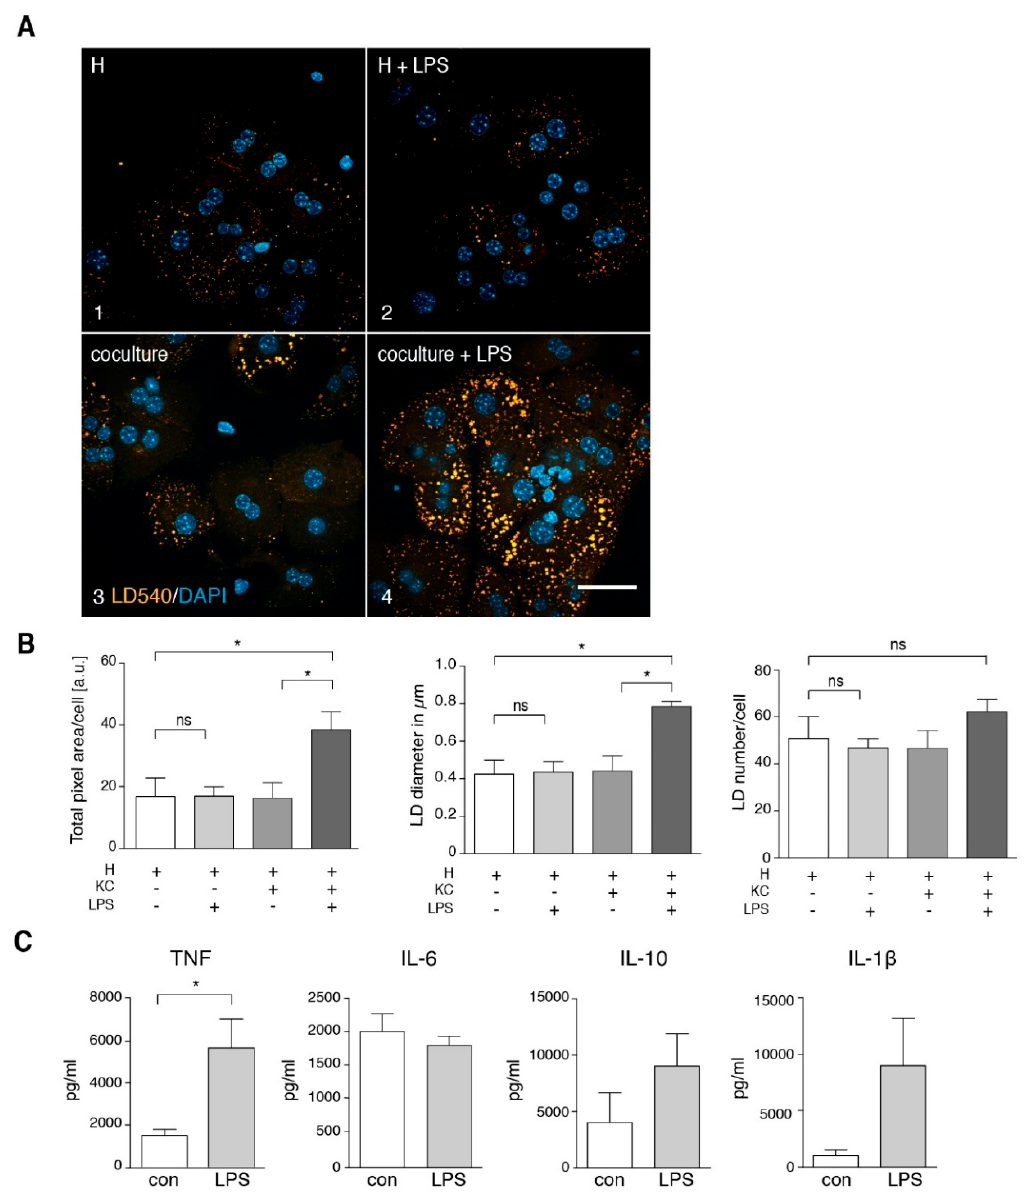
Figure 7. Intracellular lipid droplet accumulation in hepatocytes upon in vitro LPS treatment depends on the presence of Kupffer cells. ( A ) Primary mouse hepatocytes (H) were incubated for 16 h in the absence (frame 1) or presence of LPS in vitro (frame 2), in co-culture with Kupffer cells (KC) (frame 3) or in co-culture with Kupffer cells and LPS in vitro (frame 4). The lipid droplet (LD) accumulation is visualized by staining with LD540 (orange) and DAPI (blue). Scale bar: 50 µm. ( B ) Quantification of total fluorescent LD area und LD number per cell as well as LD size ( n = 3). ( C ) Kupffer cells were isolated, followed by 16 h of cell culture in the presence of 100 ng/mL LPS. Secreted TNF, IL-6, IL-10 and IL-1 β was measured in the Kupffer cell culture supernatant by ELISA. TNF n = 4; IL-6 n = 6; IL-10 n = 3; IL-1 β n = 3. All data are presented as mean value with SEM. Significance was analyzed with a two-tailed Student’s t-test. Statistical significance is indicated as follows: ns, not significant, * p < 0.05.